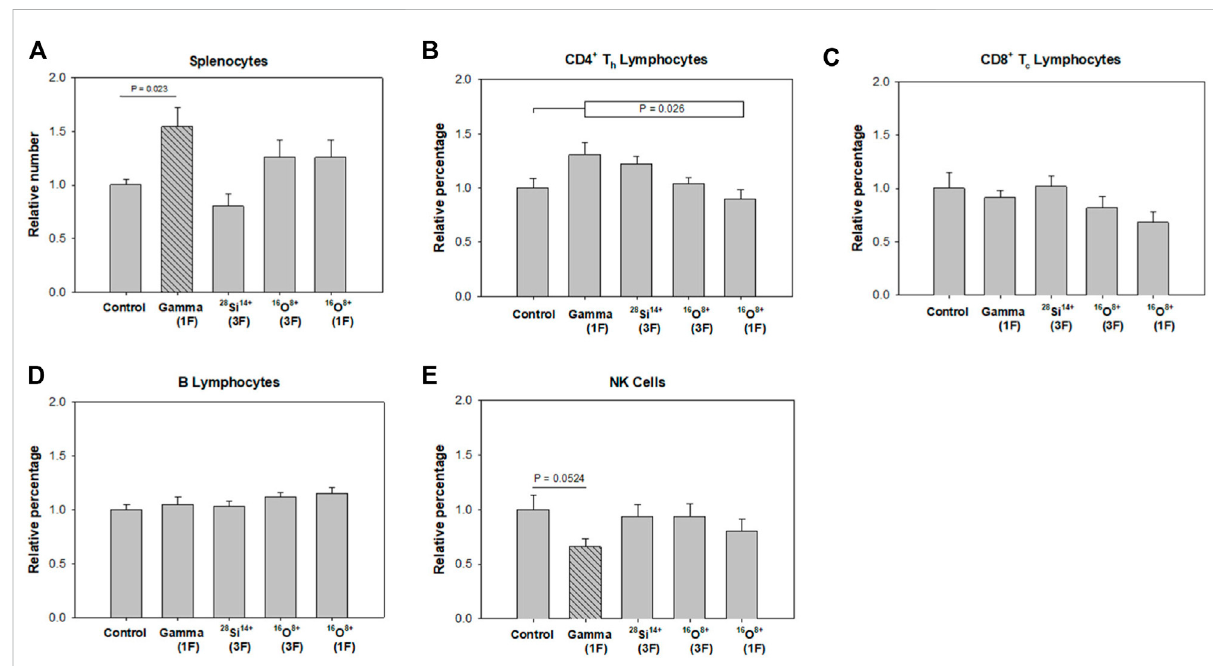
FIGURE 3 Changes in splenocyte numbers and splenocyte subpopulation percentages relative to unirradiated controls at 1 – 1.5 yr after irradiation of 10- month old mice with 0 cGy (Control, n = 13), 150-cGy gamma-rays in a single fraction [Gamma (1F), n = 6], 40-cGy 28 Si 14+ given in three fractions [ 28 Si 14+ (3F), n = 6], 40-cGy 16 O 8+ given in three fractions [ 16 O 8+ (3F), n = 12], and 40-cGy 16 O 8+ given as a single fraction [ 16 O 8+ (1F), n = 12]. (A) splenocytes, (B)